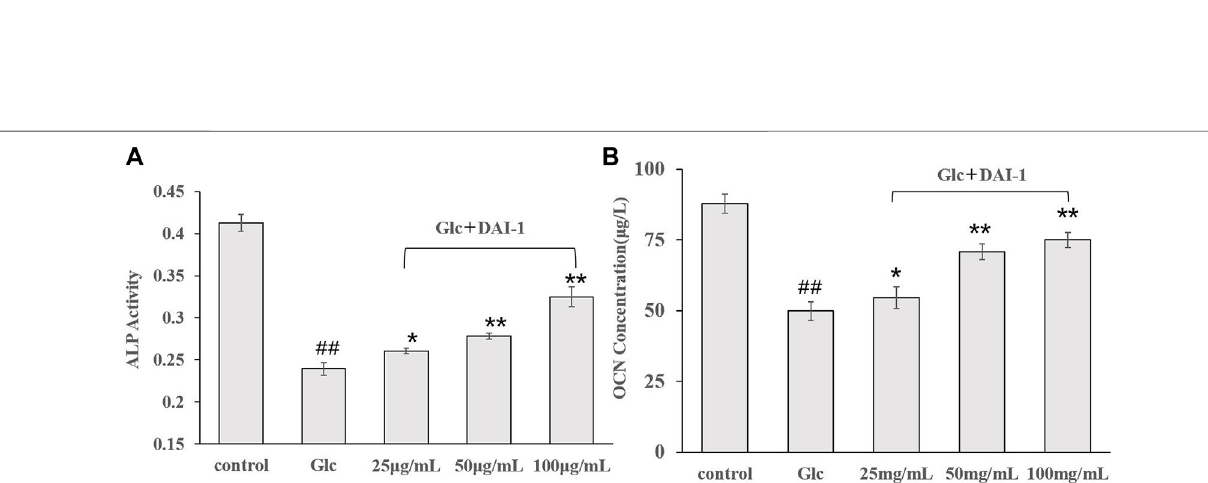
Frontiers in Pharmacology |